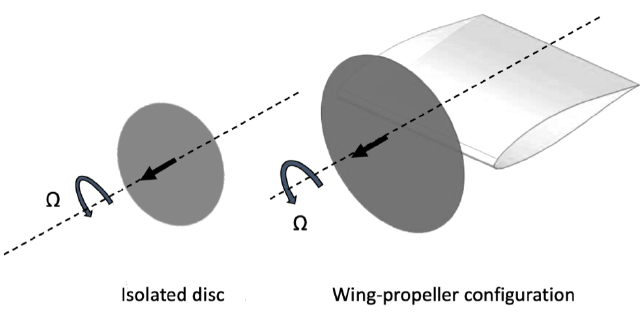
Figure 4. Pictorial view of the simulated test